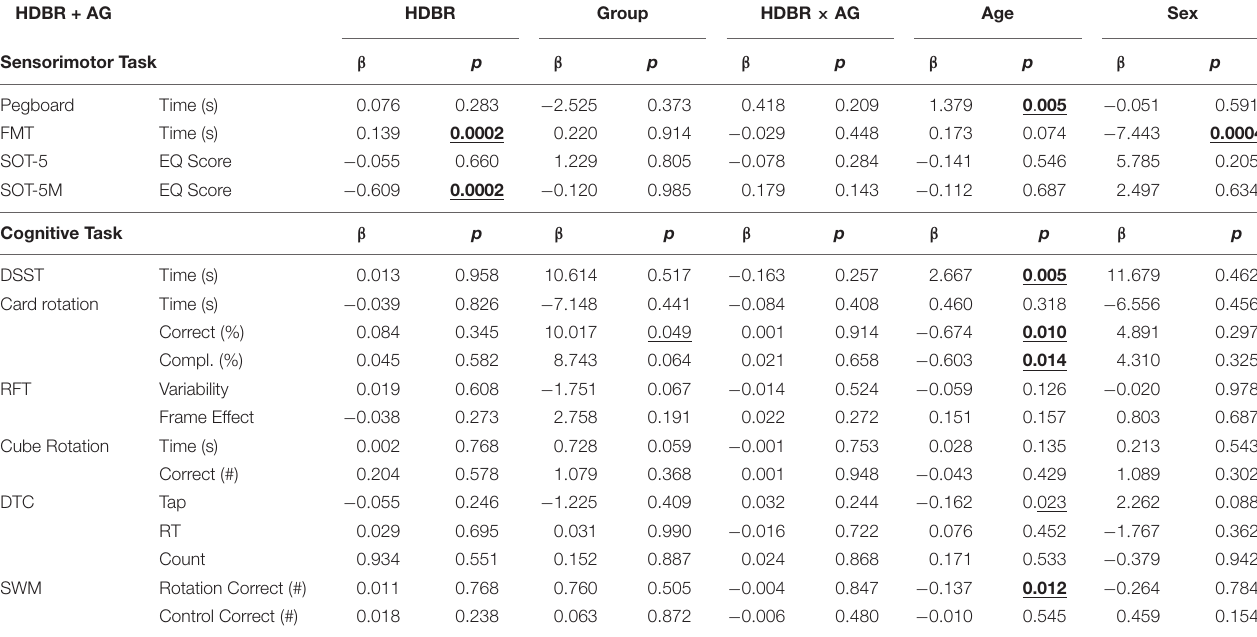
TABLE 1 | Effect of HDBR + AG environment.